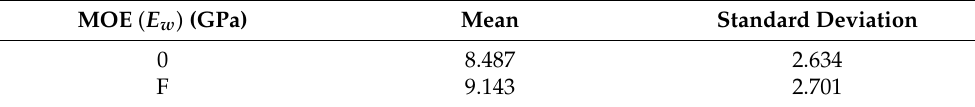
Table 3. Summary of modulus of elasticity of wood in both